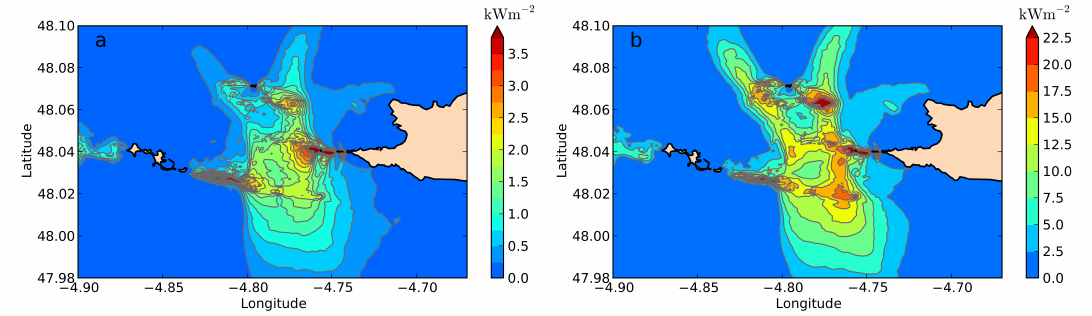
Figure 5. ( a ) Averaged and ( b ) maximum theoretical available tidal stream power during a year